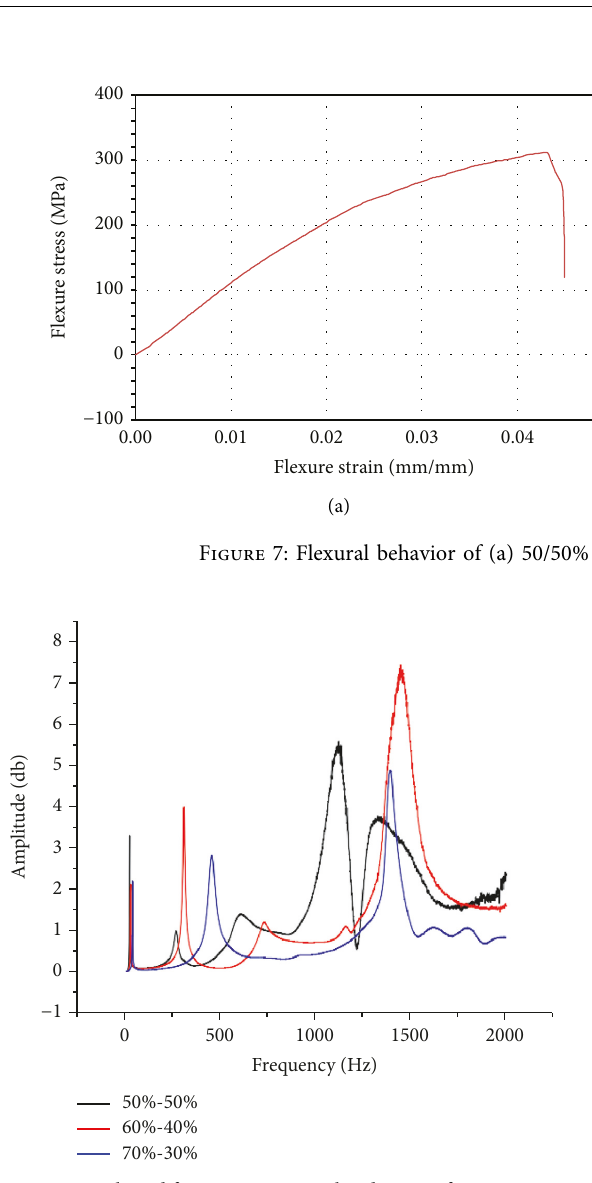
Figure 8: Combined frequency v/s amplitude curve for 50/50%, 60/ 40%, and 70/30% glass/epoxy composite